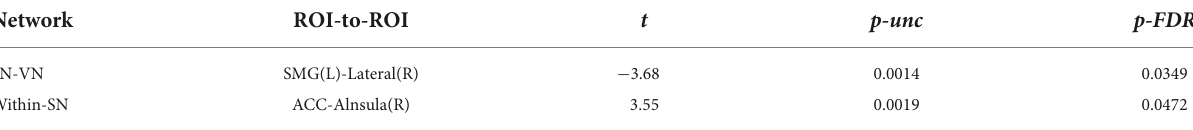
TABLE 3 ROI-to-ROI functional connectivity statistics of a network: comparison of rested wakefulness (RW) and total sleep deprivation (TSD) scans ( t -test). Network ROI-to-ROI